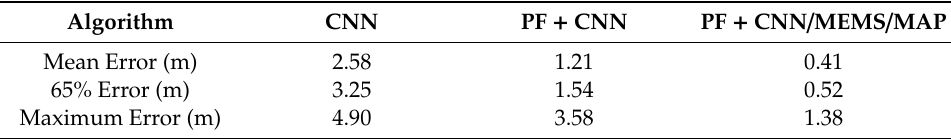
Table 2. Statistics of positioning